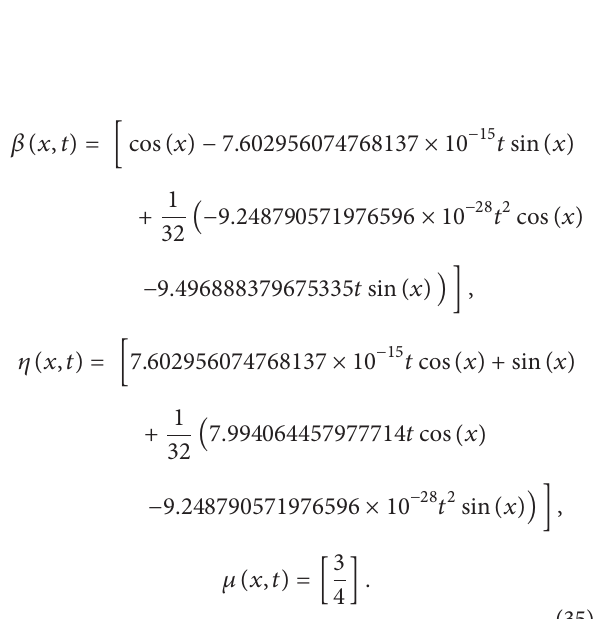
Figure 20: 2D, comparison of ordered solutions for 𝜂(𝑥,𝑡) at 𝑡 = 0.1